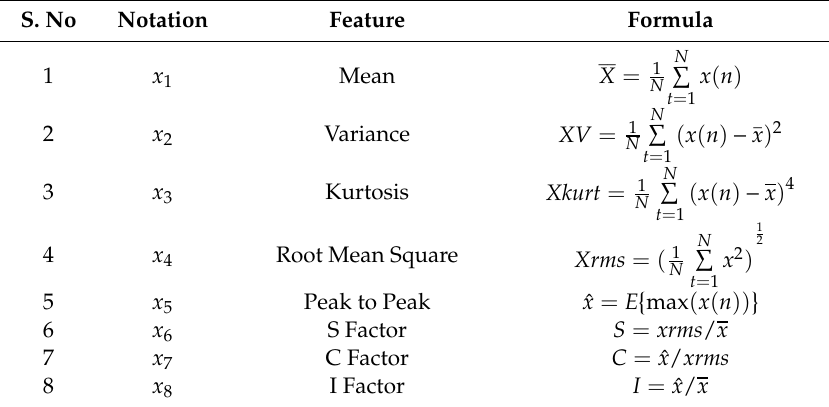
Table 2. List of statistical features and